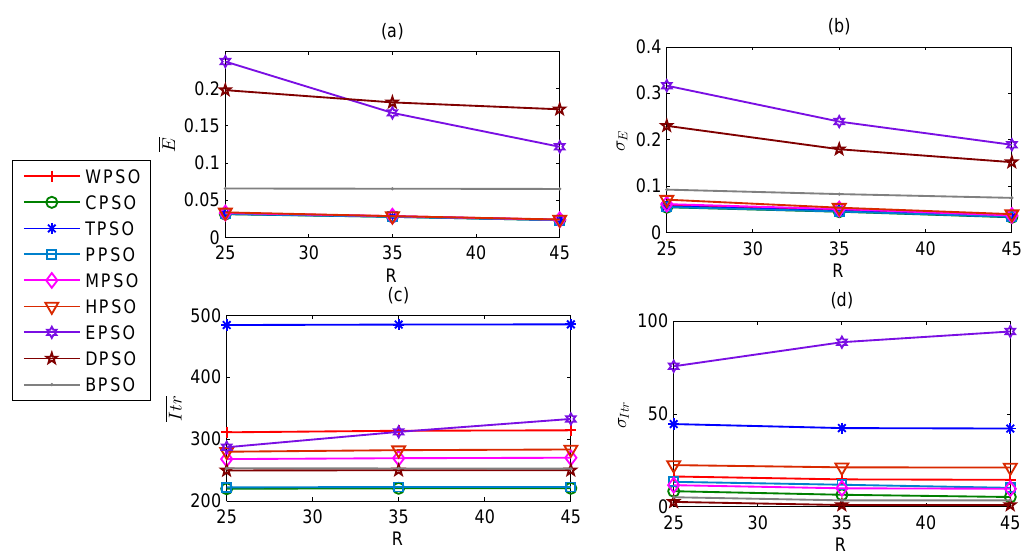
Figure 8. Impacts of R on localization performance. ( a ) E ; ( b ) σ E ; ( c ) Itr ; ( d ) σ Itr .